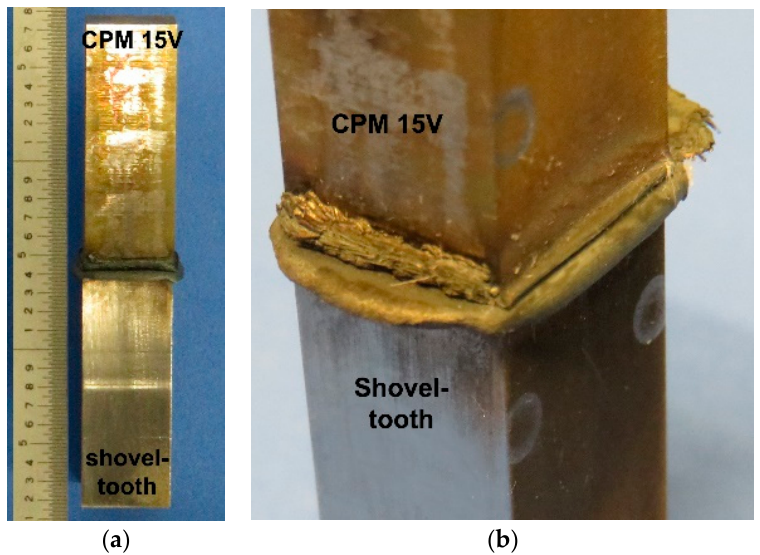
Figure 6. Front ( a ) and isometric ( b ) views of the linear friction weld between a shovel-tooth and CPM 15V tool steel (HF condition).